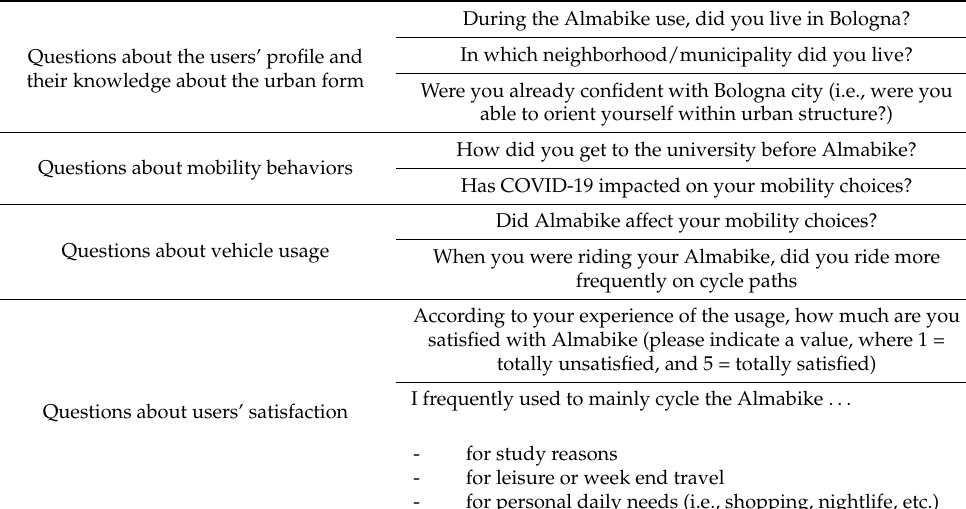
Figure 4. Proximity to discontinuities records. Table 1. Questions of the online survey for Almabike